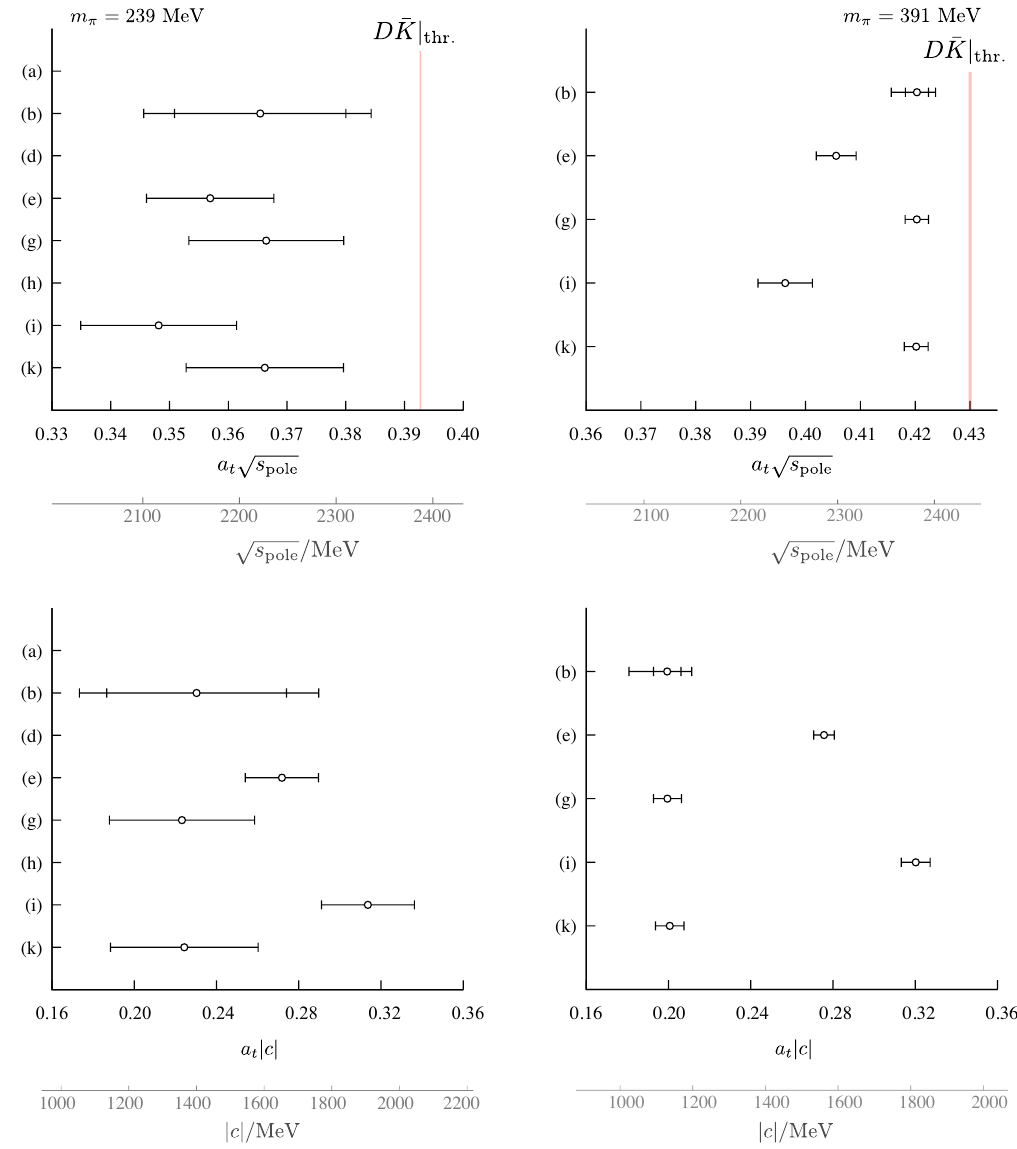
Figure 18 . Upper : the location of the pole singularity on the real axis of the unphysical sheet in the I = 0 D ¯ K S -wave scattering amplitudes, for acceptable parametrisations in table 5, on the m π = 239 MeV (left) and m π = 391 MeV (right) ensembles. The error bars give the statistical uncertainty, and the outer error bars on the reference amplitudes include also the uncertainty from varying the D and K meson masses and the anisotropy, as well as a covariance-adjusted fit as described in the text. The red band shows the location of D ¯ K threshold. Lower : the corresponding coupling, | c |